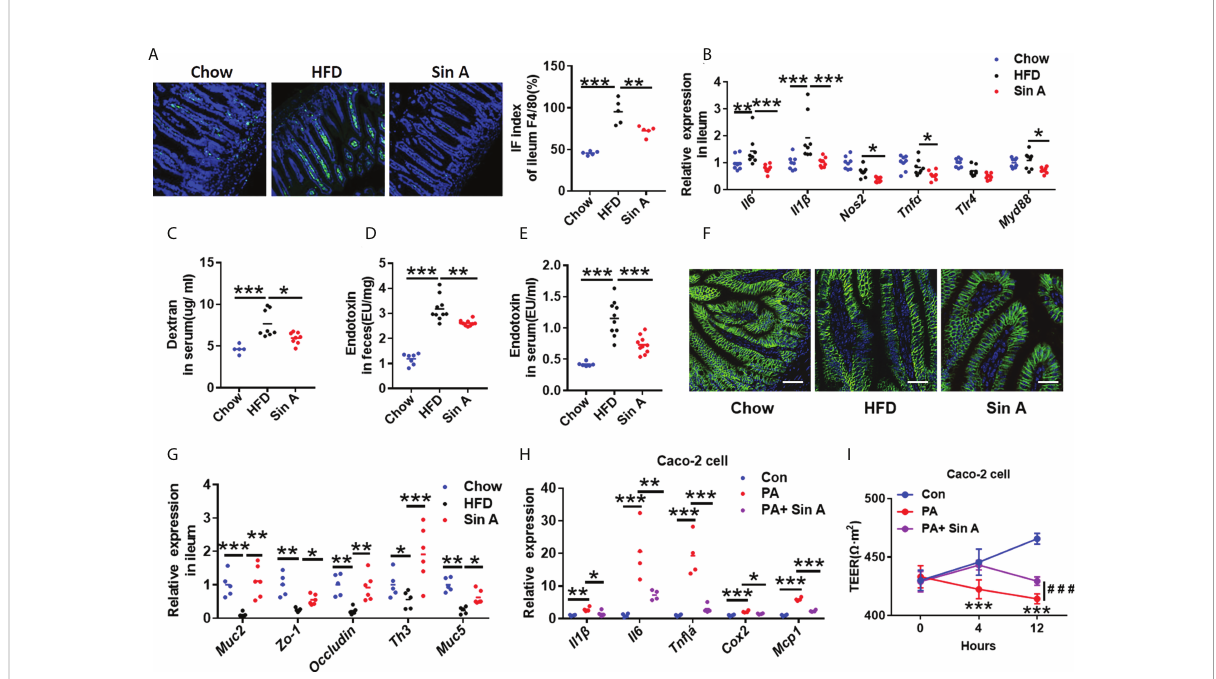
FIGURE 3 Sin A attenuates gut in fl ammation and restores intestinal barrier function. Chow-fed mice were treated daily with normal diet (Chow). HFD-fed mice were orally treated with vehicle (HFD) or Sin A (80 mg/kg) for 6 weeks. (A) Representative images of F4/80 staining of ileum tissue (Scale bars 10 m m), Right: IF index of ileum F4/80 (%) ( n =5 per group). (B) The changes in in fl ammation response-associated genes in ileum ( n =8 per group). (C) Changes in dextran concentration in blood 4 h after Dextran-FITC gavage in HFD and Sin A mice ( n =8 per group). Results of endotoxin in (D) feces and (E) serum of mice ( n =10 per group). (F) Immuno fl uorescence for occluding-1 protein in ileum sections. Scale bars 10 m m. (G) Results of gene expression related to ileum tight junction molecules ( n =5 – 8 per group). (H) Results of Qpcr associated with in fl ammatory mediators in Caco-2 cell after LPS and Sin A incubation for 24 h. (I) Changes in transepithelial electrical resistance (TEER) in control, LPS, and LPS+ Sin A groups for the indicated times. Values represent mean ± SD. Signi fi cance was determined by Student ’ s t -test for the two-group and one-way ANOVA for the multiple-group comparisons. p *<0.05; ** p <0.01; *** p <0.001. Il6, interleukin 6; Il1 b , interleukin 1 beta; Tlr4, toll-like receptor4; Myd88, myeloid differentiation 88; Muc2, mucin2; Zo-1, zonula occludens-1; Th3, Muc5, mucin5; Tnfa, tumor necrosis factor a ; Cox2, Cyclooxygenase-2;